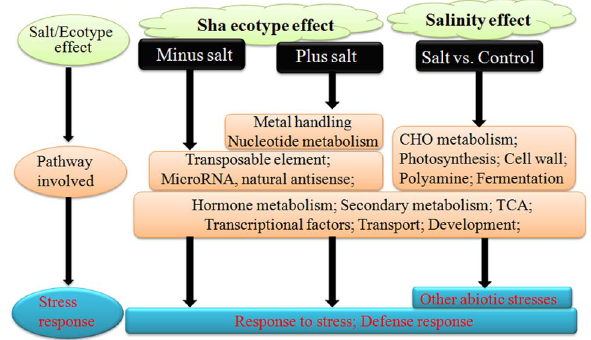
Figure 7. Model of salt effect and ecotype effects. doi:10.1371/journal.pone.0069036.g007 PLOS ONE |